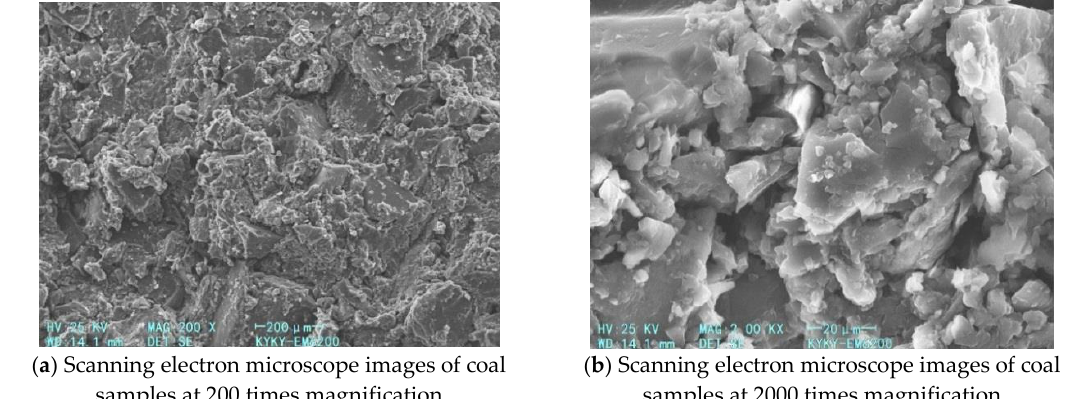
Figure 3. Scanning electron microscope images of the prepared coal samples.